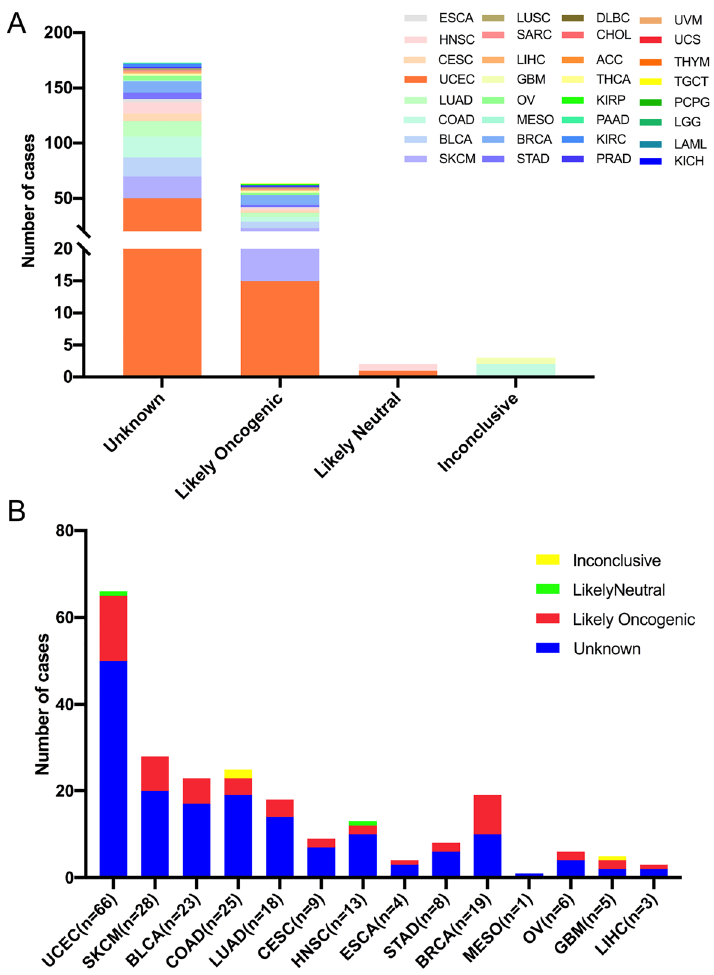
Figure 4. The distribution of BRIP1 mutations based on functional impacts. ( A ) The classification of BRIP1 mutations according to functional effects on various cancers collectively. ( B ) Distribution of BRIP1 mutations by functional impact class in the top 14 cancer